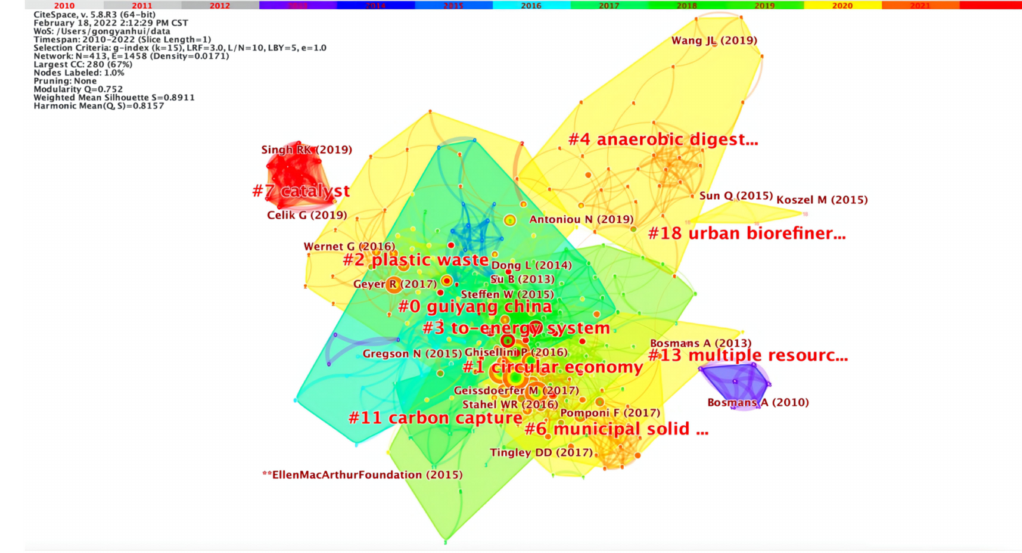
Figure 7. Co-citation cluster map of literature (2010–2021).